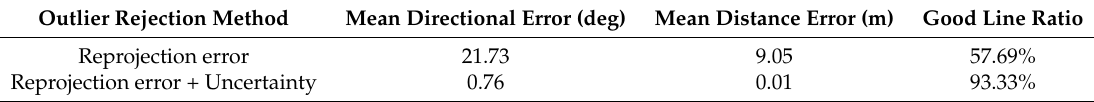
Figure 10. Outlier rejection with and without uncertainty. The first row shows reconstructed lines only with reprojection error based outlier rejection: ( a ) reconstructed line segments on the reference frame; ( b ) front view of reconstructed 3D lines. ( c ) Side view of reconstructed 3D lines. The second row shows reconstructed lines that pass reprojection error and uncertainty tests: ( d ) reconstructed line segments on the reference frame; ( e ) front view of reconstructed 3D lines. ( f ) Side view of reconstructed 3D lines. Table 1. 3D line map quality after outlier rejection with different